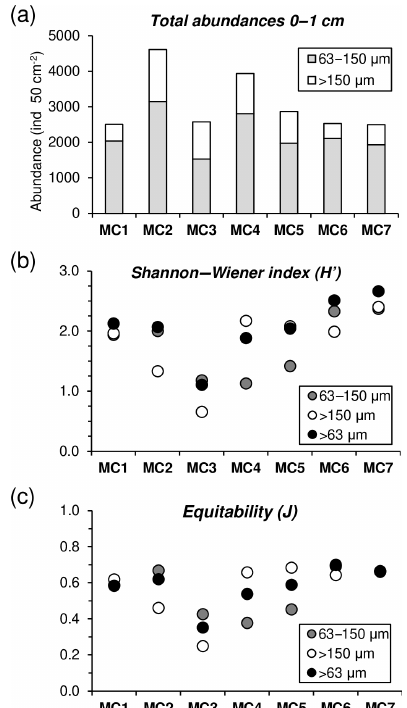
Figure 6. (a) Foraminiferal cumulative abundances (ind. 50cm − 2 ) for two size fractions (63–150µm, grey, and > 150µm, white) of the 0–1cm sediment layer. (b) Shannon–Wiener ( H (cid:48) ) and (c) equi- tability ( J ) indexes comparison among the 63–150µm, > 150µm and > 63µm (black)